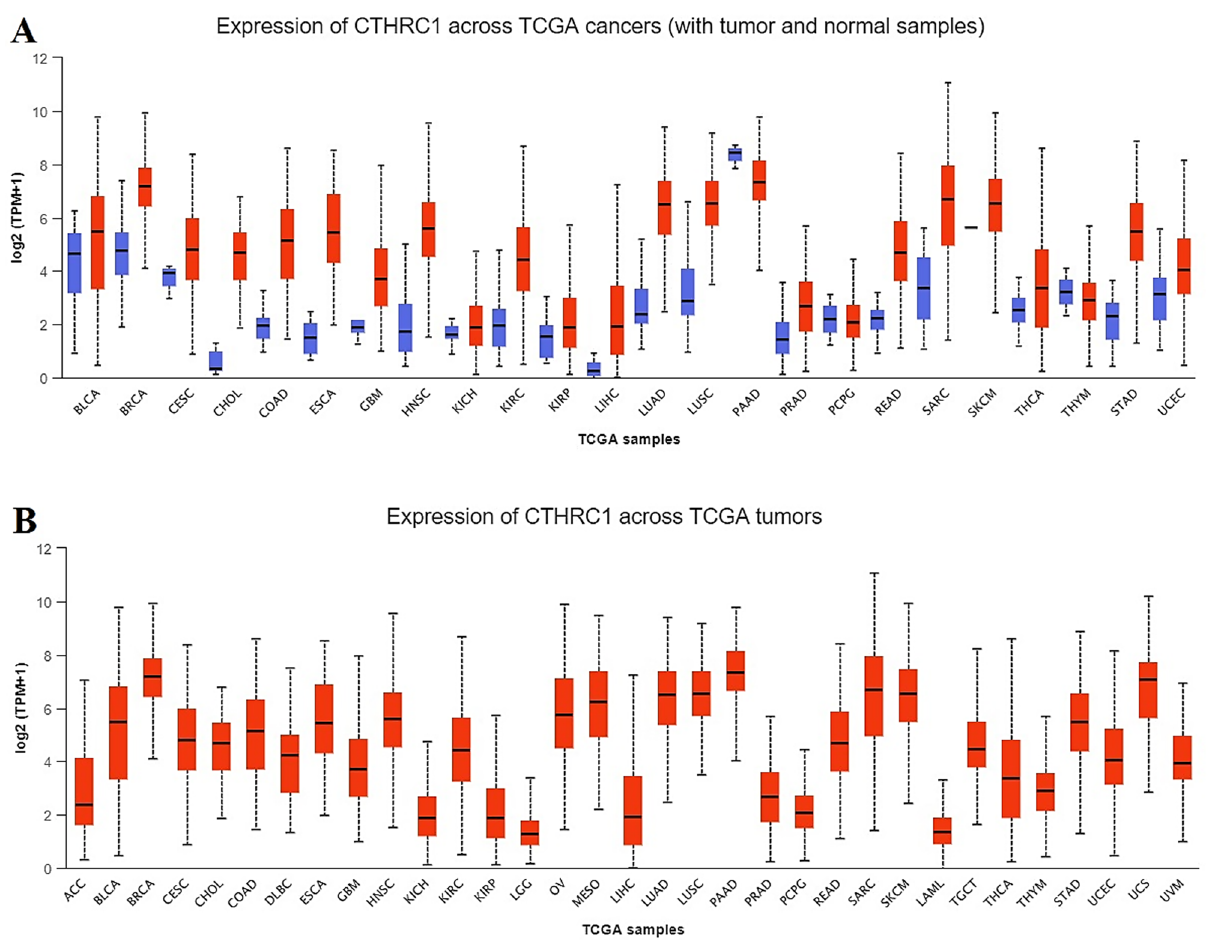
Figure 1. CTHRC1 transcription expression level in 24 human cancer subtypes. ( A ) CTHRC1 expression across cancerous samples paired with normal controls, and ( B ) CTHRC1 expression across cancerous samples without paired normal controls (p <